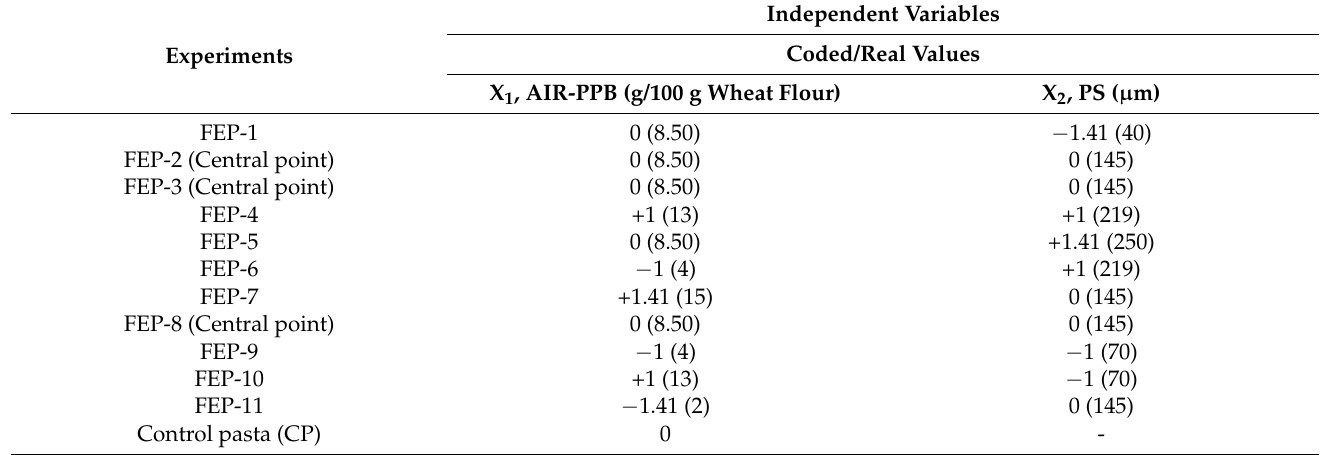
Table 1. Experimental design values for fiber-enriched pasta (FEP) with different combinations